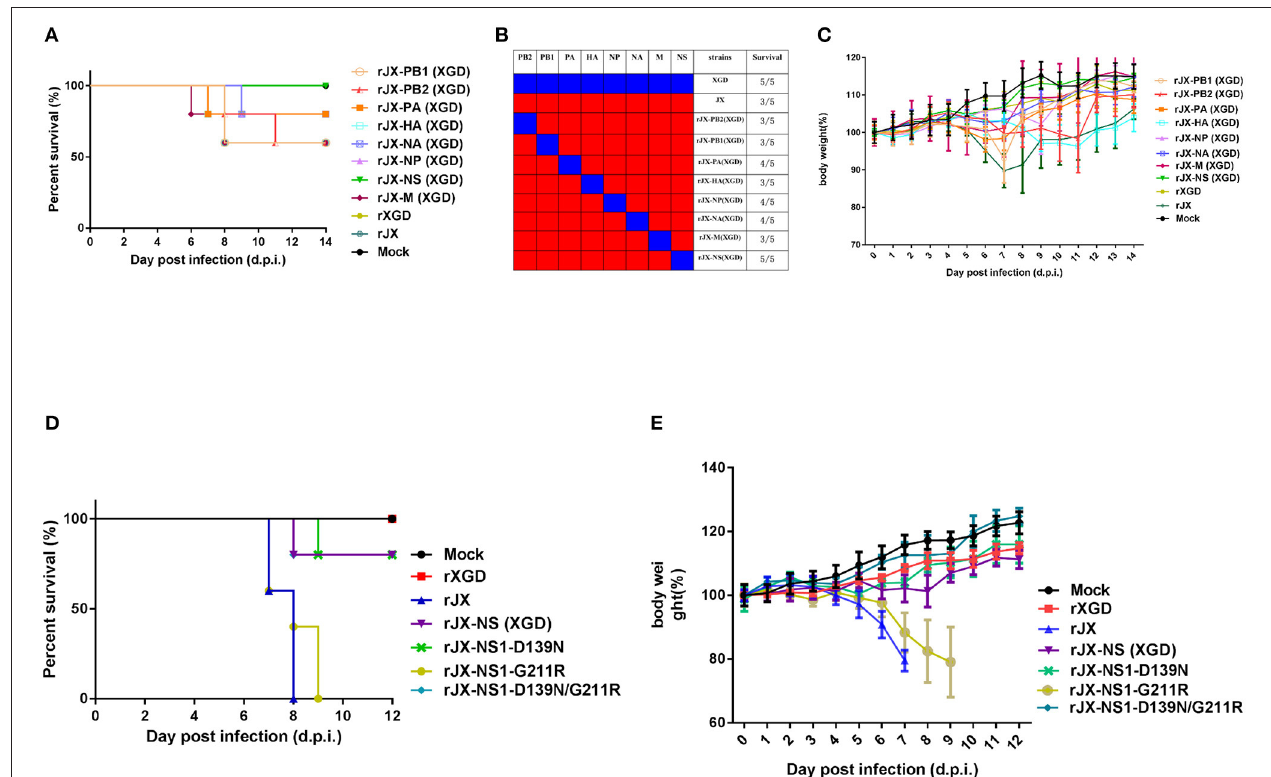
FIGURE 6 | Pathogenicity of recombinant or mutant viruses. Groups of mice ( n = 5) were intranasally infected with 10 3.7 TCID 50 of recombinant viruses. The infected mice were observed to monitor survival (A,B) and weight loss (C) for 14 days post-infection (d.p.i). Groups of mice ( n = 5) were intranasally infected with 10 5 TCID 50 of NS1 mutant viruses. The infected mice were observed to monitor survival (D) and weight loss (E) for 12 dpi.